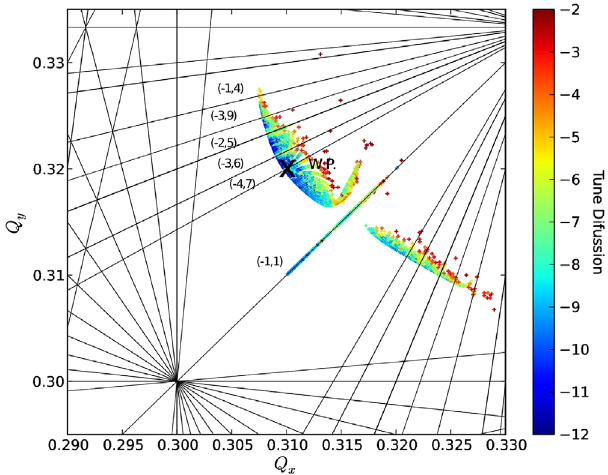
FIG. 18. Diffusion factor on a tune map for the initial angles varying from 0 – 90 degrees and initial amplitudes I ¼ 0 – 22 σ over a resonance diagram of order 12 for the lattice with L (cid:1) ¼ 17 m and β (cid:1) ¼ 10